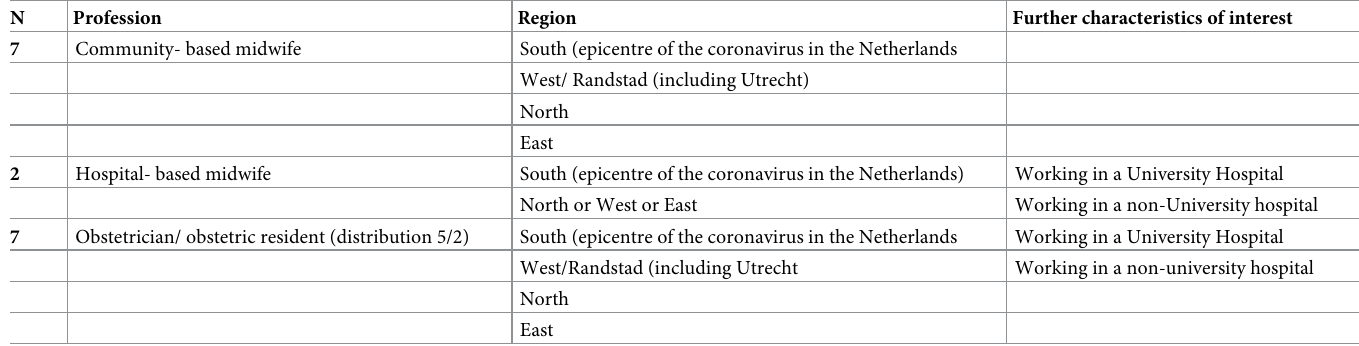
Table 1. Sampling